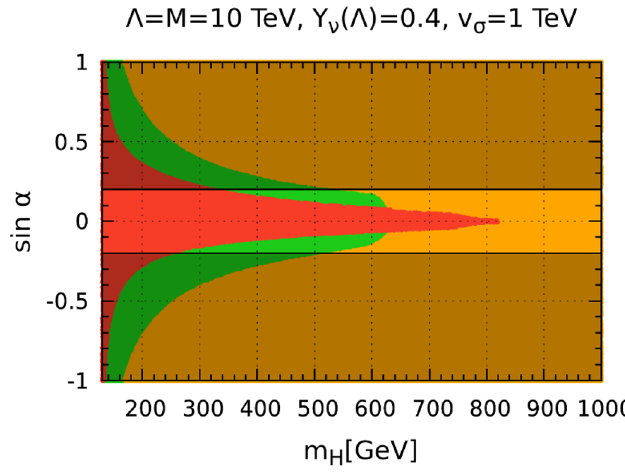
Figure 12 . Values of m H and mixing angle α leading to a stable potential (green), an unstable potential (red) and non-perturbative dynamics (orange). Here we take the (3,1,1) missing partner majoron inverse seesaw as the reference, with the heavy fermion threshold scale fixed as Λ = 10 TeV, Yukawa coupling Y ν = 0 . 4 and v σ = 1 TeV. Within the green region all couplings are perturbative and the vacuum is stable up to the Planck scale. In the red region the potential becomes unbounded from below before the Planck scale. The orange region has nonperturbative couplings (including Landau poles) at energy scales below the Planck scale. The region outside the horizontal band delimited by the black lines is ruled out by the LHC constraints on invisible Higgs decays. More details in